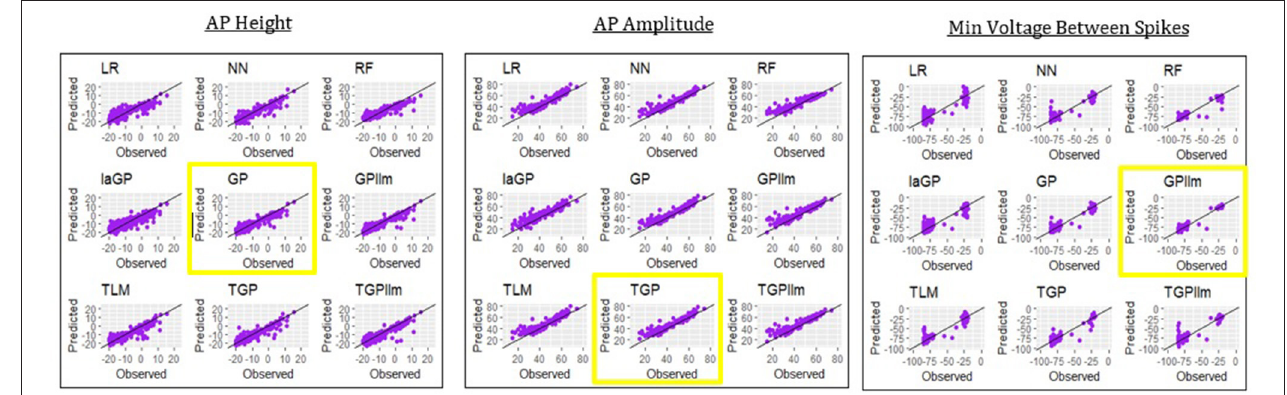
FIGURE 8 | Observed (i.e., simulated) vs. predicted (i.e., emulated) values for the three electrical features which are not always observed, using the data from generation 6, for each of the nine emulation methods considered here.